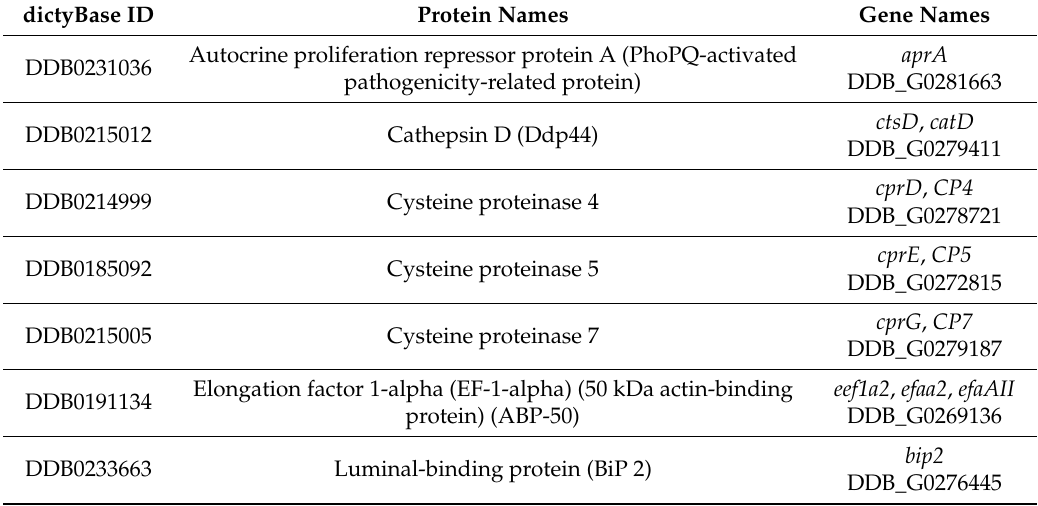
Table 1. Proteins present in Cln5-GFP IP fractions that are differentially secreted by cln3 −